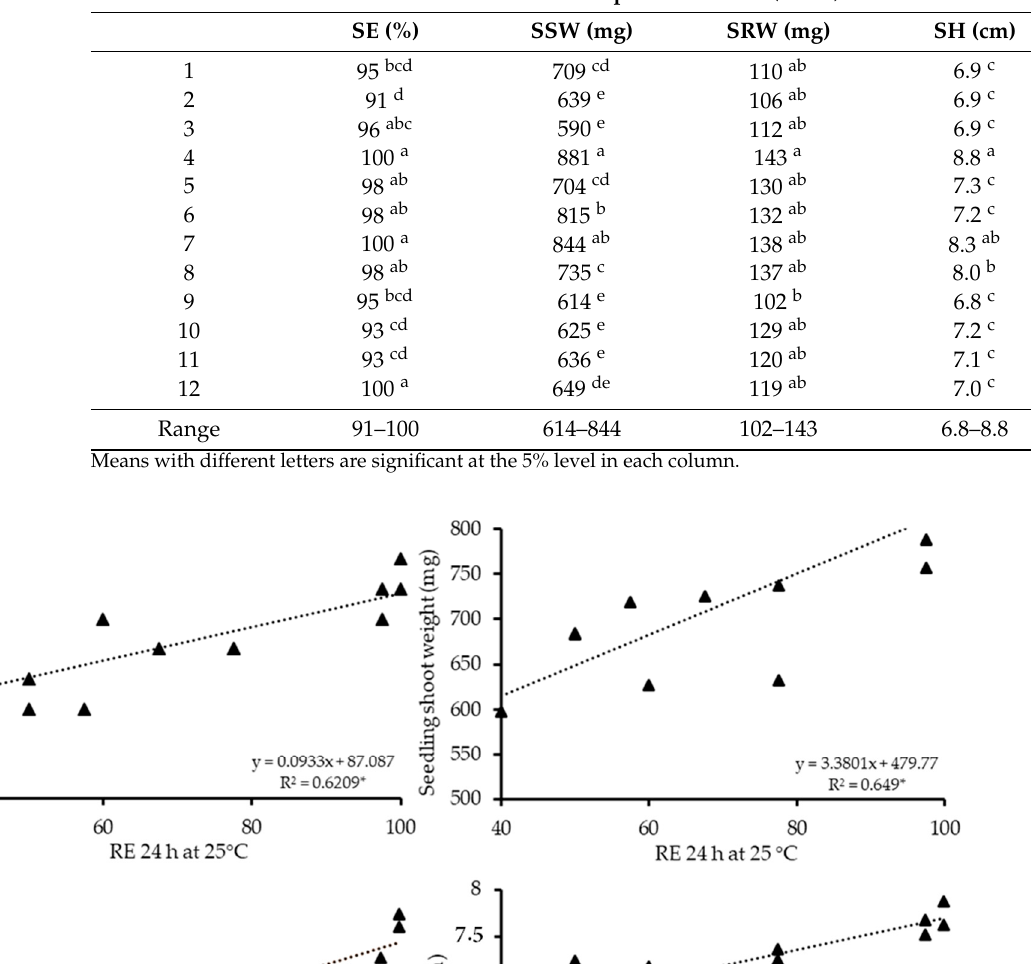
Table 2. Variation in seedling emergence (SE, %), seedling shoot weight (SSW, mg), seedling root weight (SRW, mg) and seedling height (SH, cm) with low temperature stress. Means with different letters are significant at the 5% level in each column.